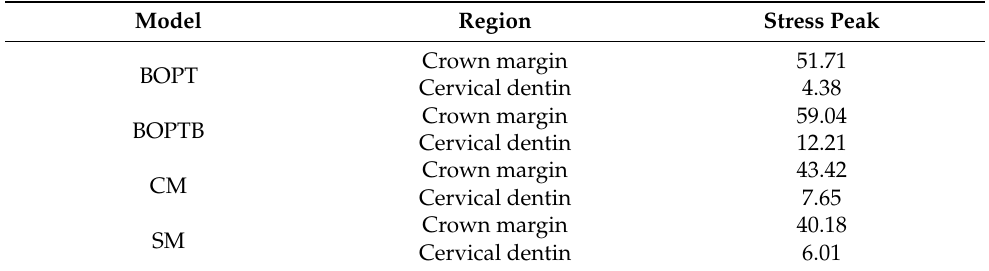
Table 2. Stress peaks (MPa) in the crown margin and cervical dentin according to the preparation